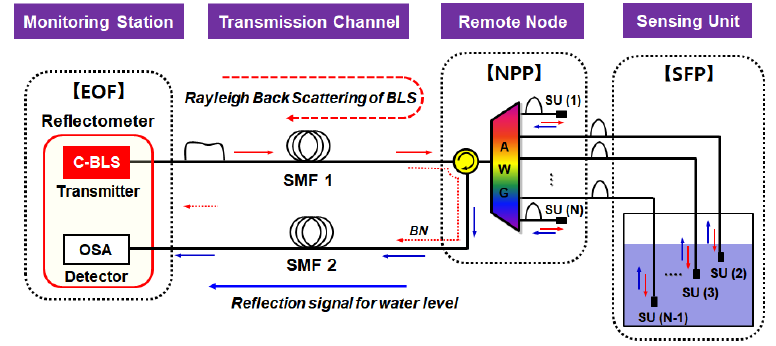
Figure 5. Configuration of proposed network for mitigation of Rayleigh back-scattering (RBS) effect.